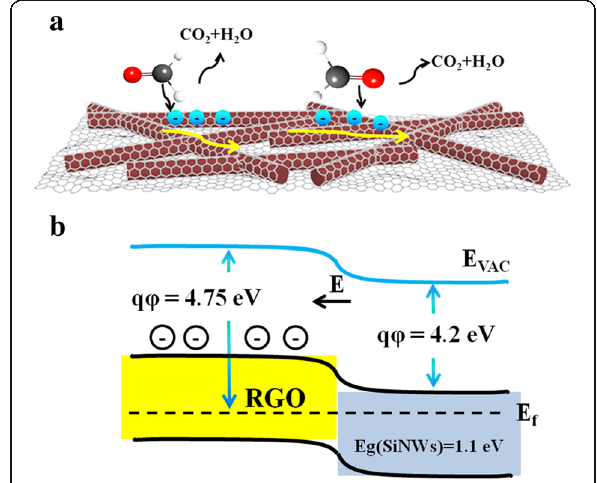
Fig. 8 a Schematic diagram of the mechanism of HCHO molecules detection. b The band structures diagram of the RGO/n-SiNW